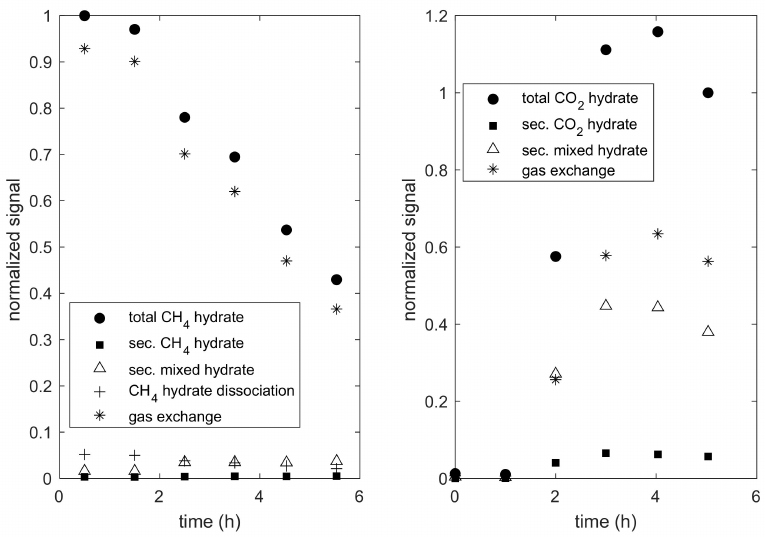
Figure 12. Evolution of the total gas hydrate signal during the flow period of experiment Flow and evolution of the specific processes. Left: CH 4 hydrate; right: CO 2